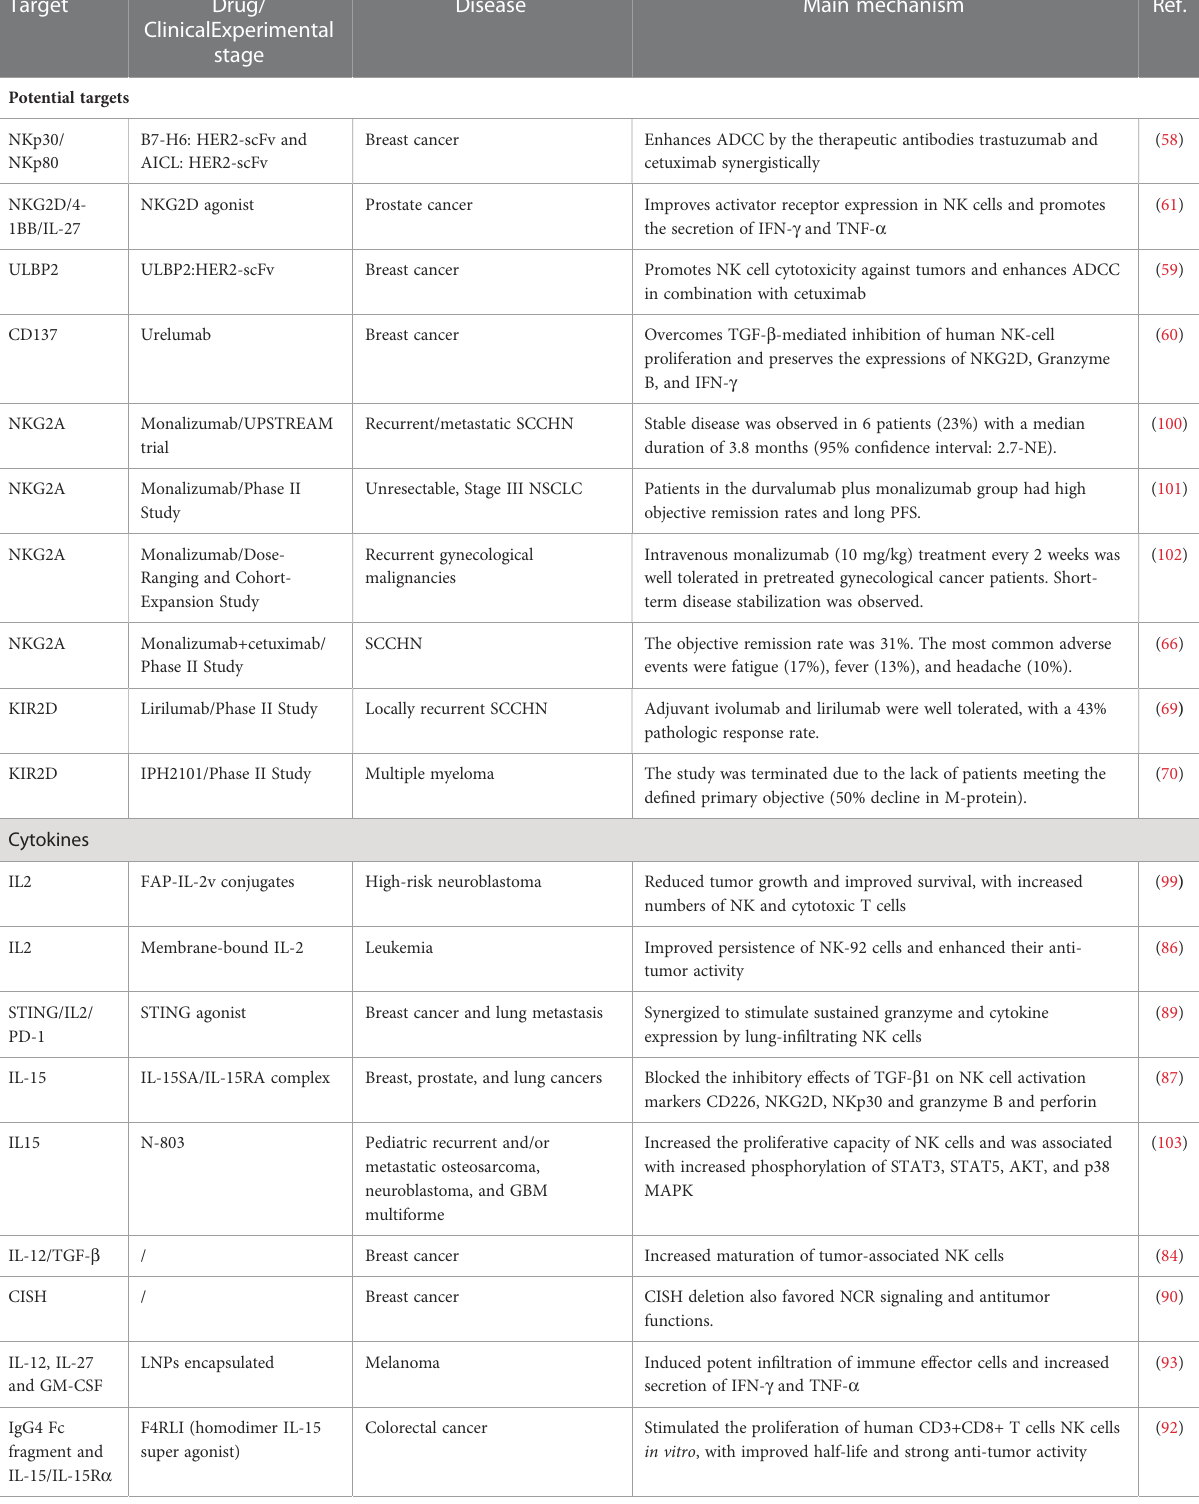
TABLE 2 Strategies for potential targets and cytokines to enhance NK cells and